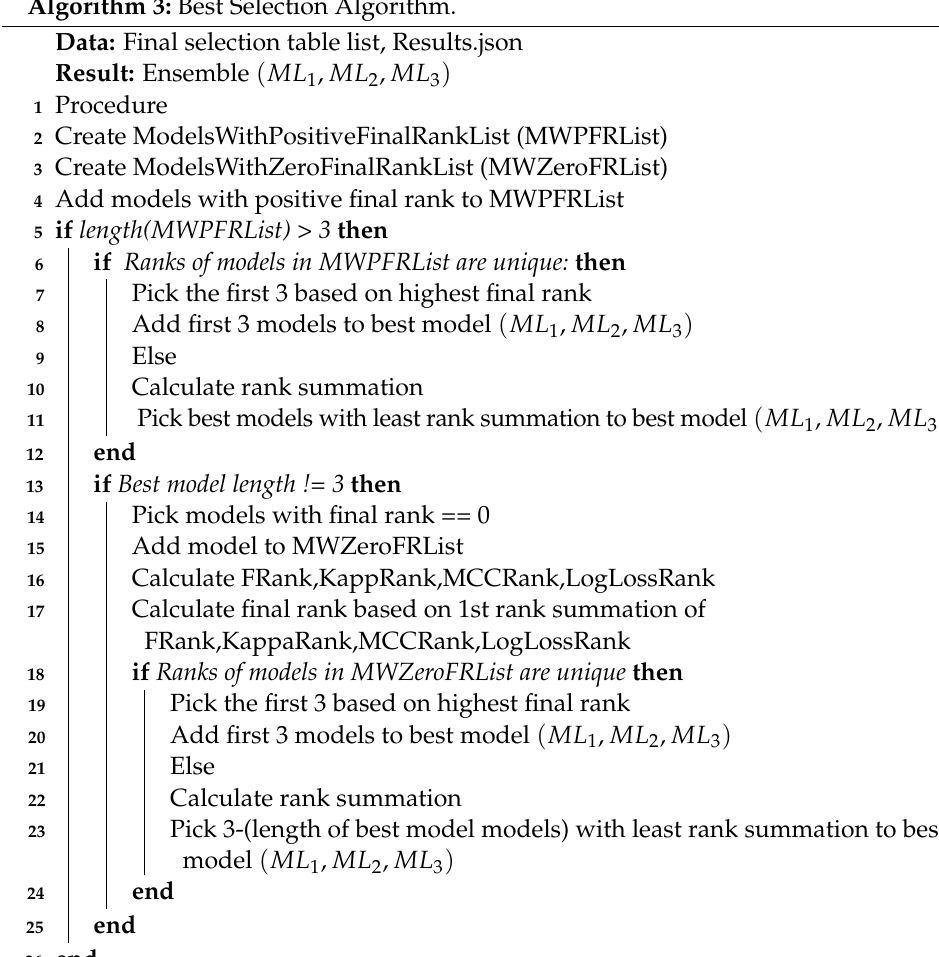
Algorithm 3: Best Selection Algorithm. Data: Final selection table list,